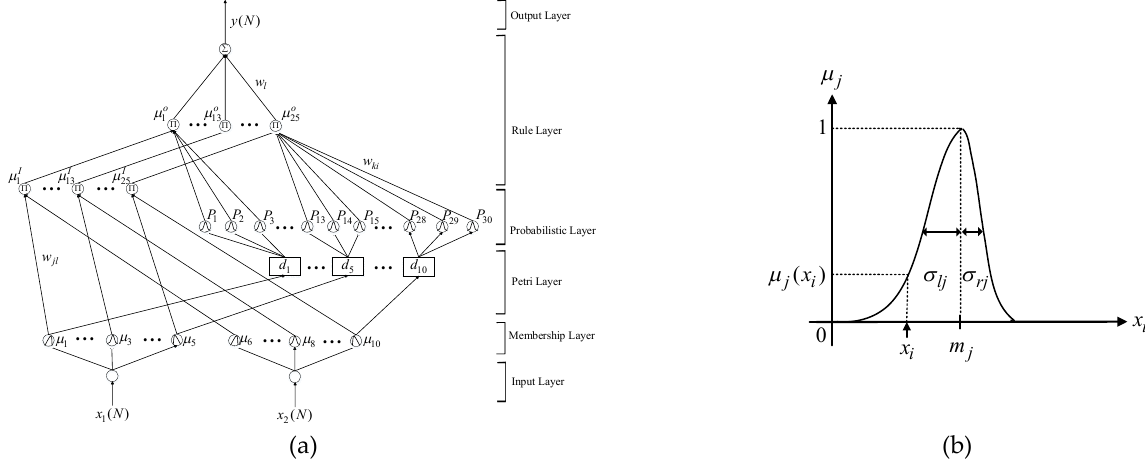
Figure 2. Petri probabilistic fuzzy neural network with an asymmetric membership function (PPFNN-AMF): ( a ) Network structure; ( b ) asymmetric Gaussian function in the membership layer.